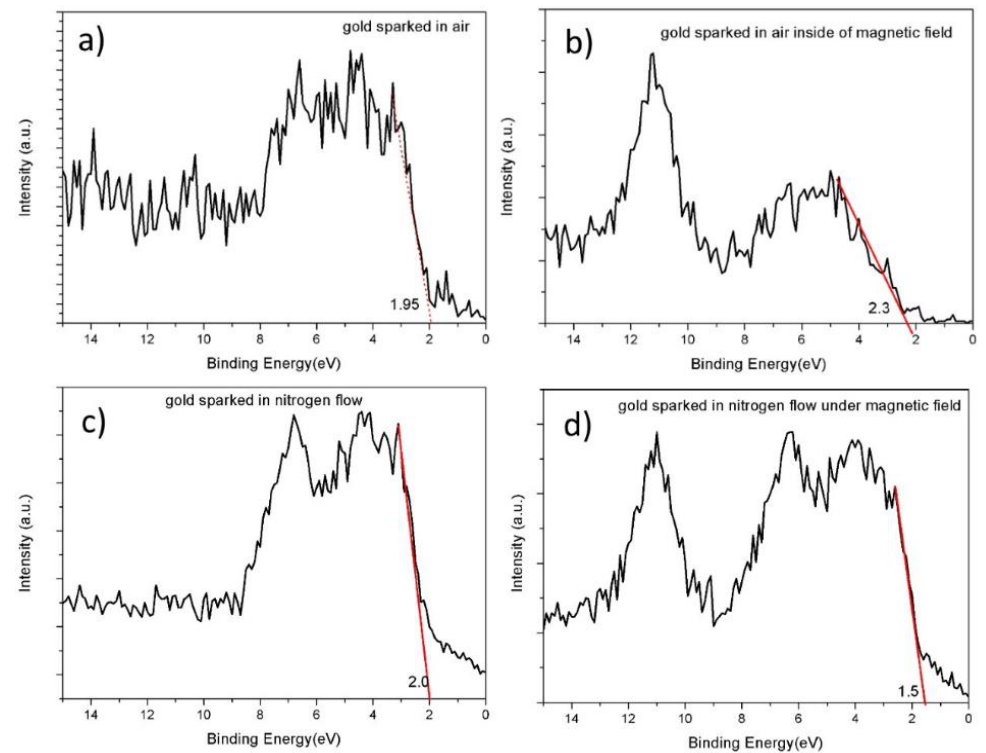
Figure 7. Au valence band of gold ( a ) sparked in ambient air, ( b ) sparked in ambient air inside of magnetic field, ( c ) sparked in nitrogen flow, and ( d ) sparked in nitrogen flow inside of magnetic field.